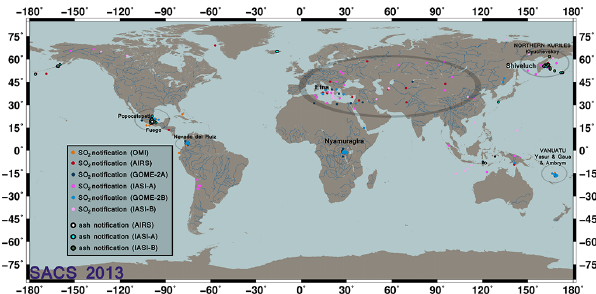
Fig. 25. SACS notifications for 2013.